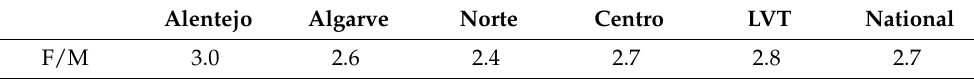
Table 1. Female and male ratio in terms of BZD-DDD prescriptions over the 3 years. Alentejo Algarve Norte Centro LVT National